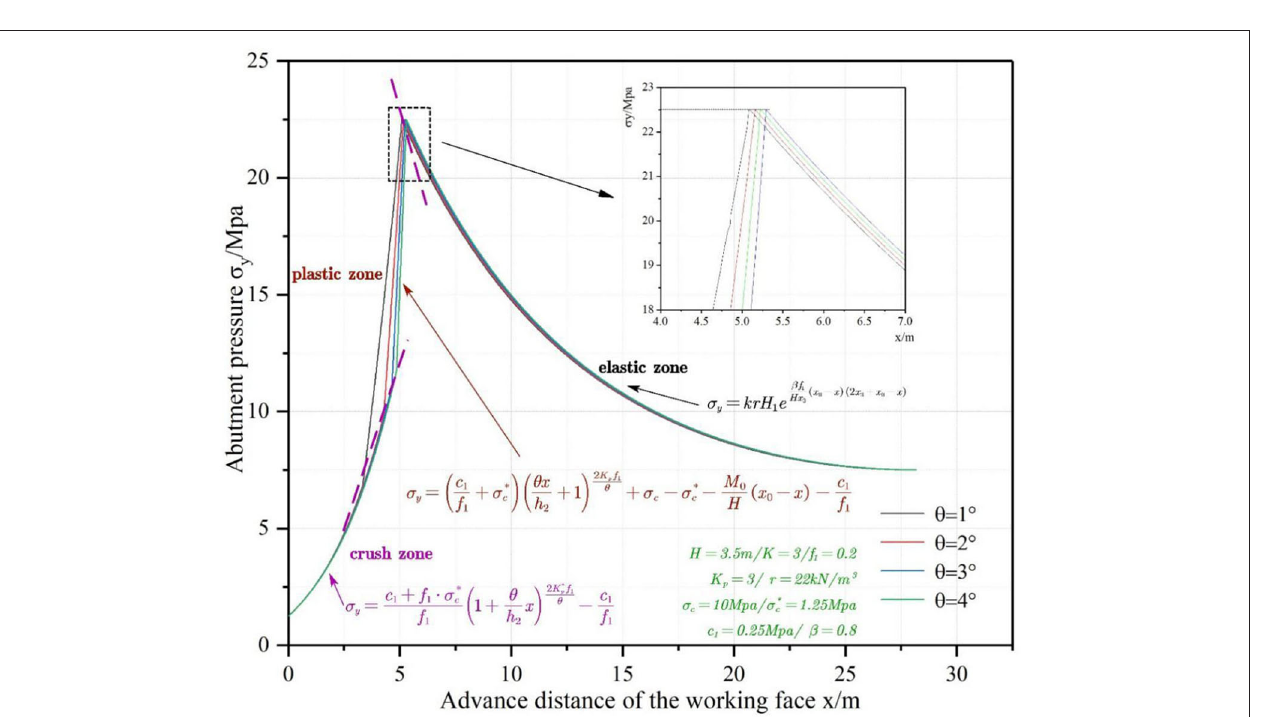
FIGURE 5 | Impacts of deformation angle on abutment pressure.